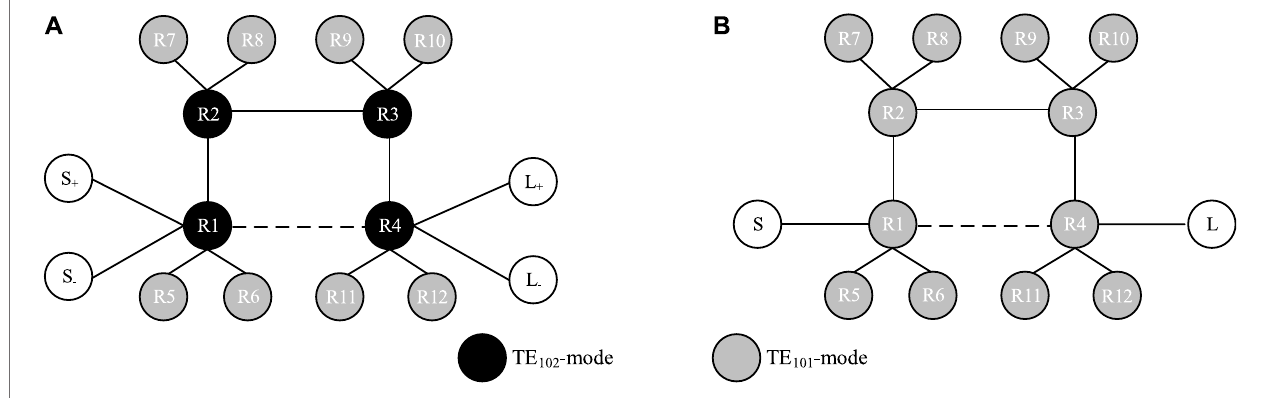
FIGURE 3 | Topologies of proposed balanced tri-band BPF. (A) Four-port schematic topology, (B) Equivalent two-port DM topology.